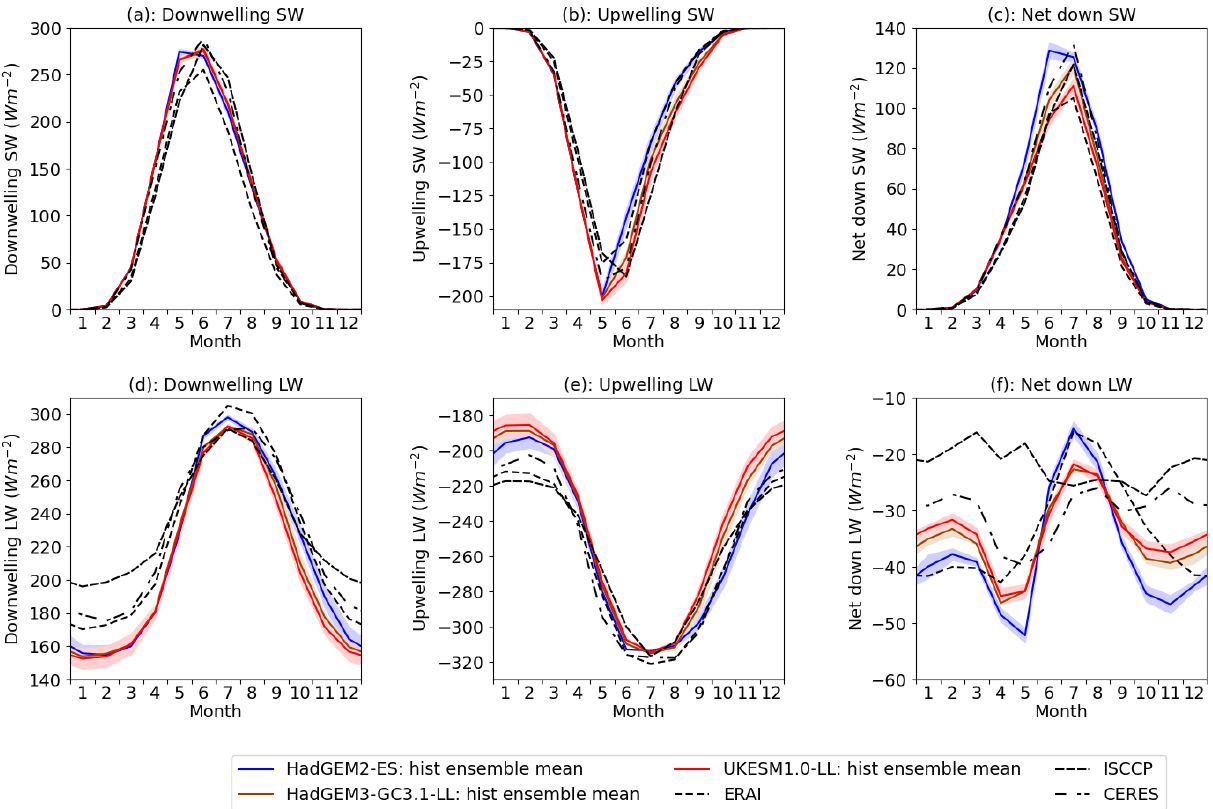
Figure 3. (a) Downwelling SW, (b) upwelling SW, (c) net downwards SW, (d) downwelling LW, (e) upwelling LW and (f) net downwards LW from 1980–1999 in HadGEM2-ES, HadGEM3-GC3.1-LL and UKESM1.0-LL, together with observational estimates from ISCCP-FD, ERAI and CERES, averaged over the Arctic Ocean region. For each model, ensemble mean (lines) and twice the standard deviation (shading) is shown. For all fluxes, the convention is that positive numbers denote downwards energy flows, and vice